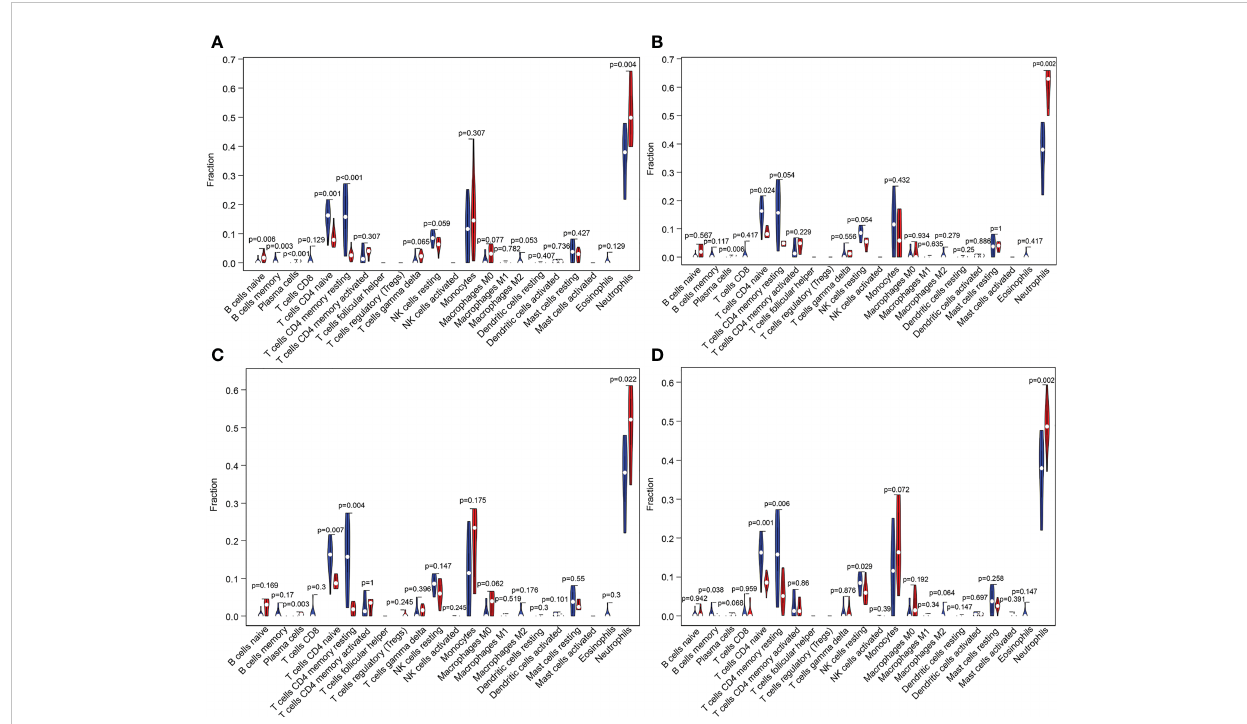
FIGURE 12 Violin plot of differences in the content of immune cells between different grades of SCI and the HC group analyzed using the CIBERSORT algorithm. (A – D) Changes in immune cells in the blood of patients with SCI AIS A, AIS B, AIS C and AIS D grades using the CIBERSORT algorithm. SCI, spinal cord injury; HC, healthy uninjured control; AIS, American Spinal Cord Injury Association Impairment Scale; CIBERSORT, Cell-type Identi fi cation by Estimating Relative Subsets of RNA